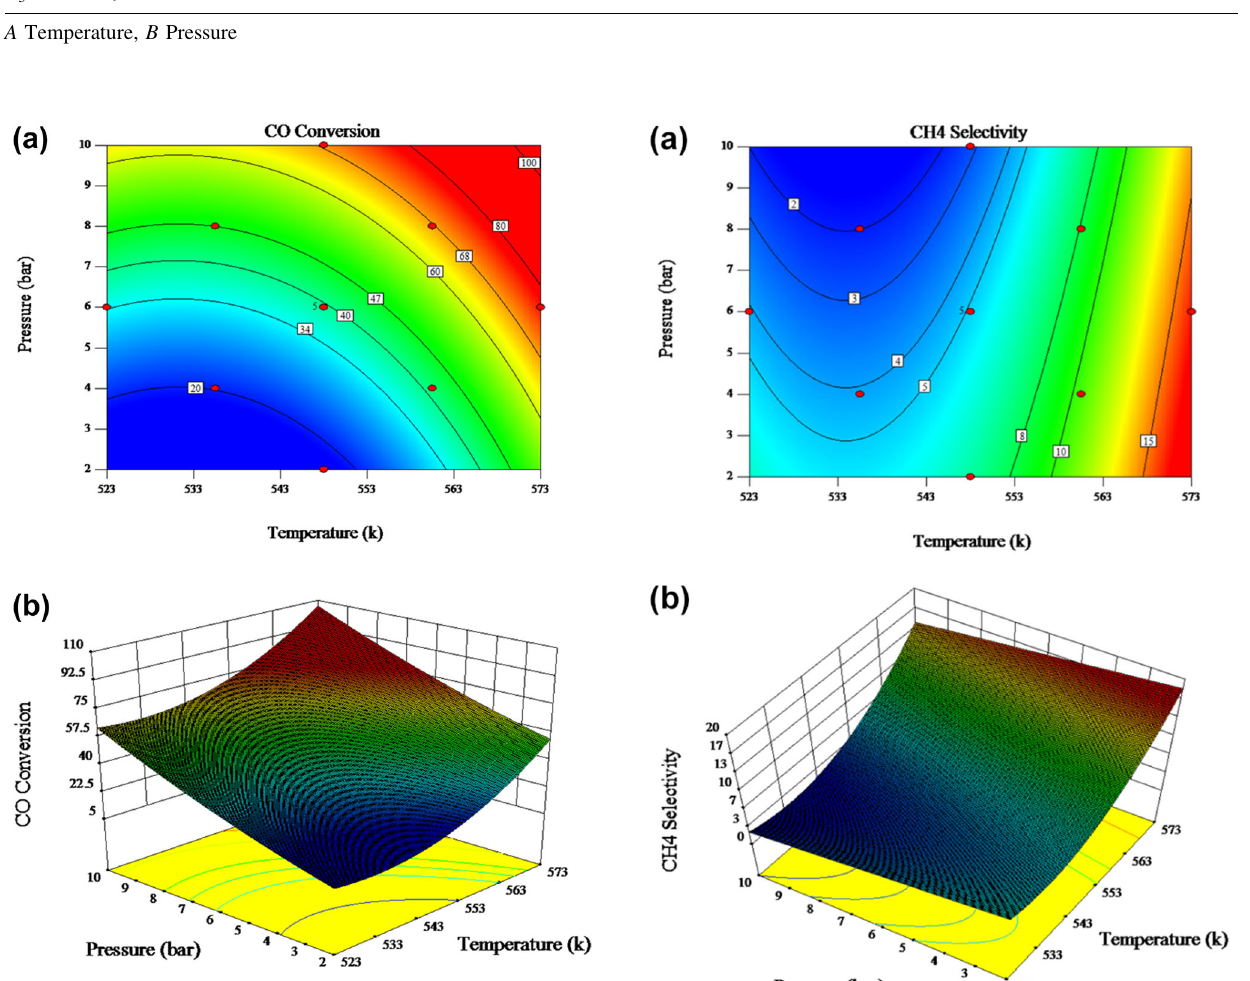
Fig. 4 Contour ( a ) and 3D surface ( b ) plots for CO conversion